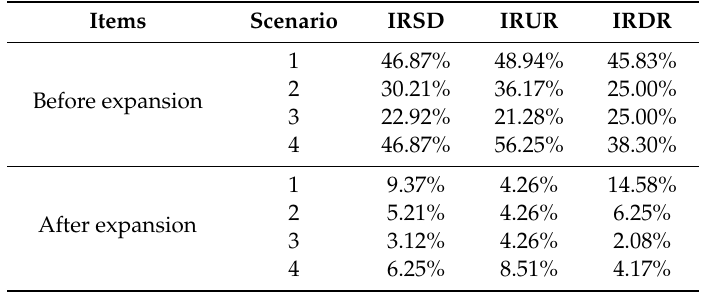
Table 3. Comparison for adaptability index of supply and demand balance.